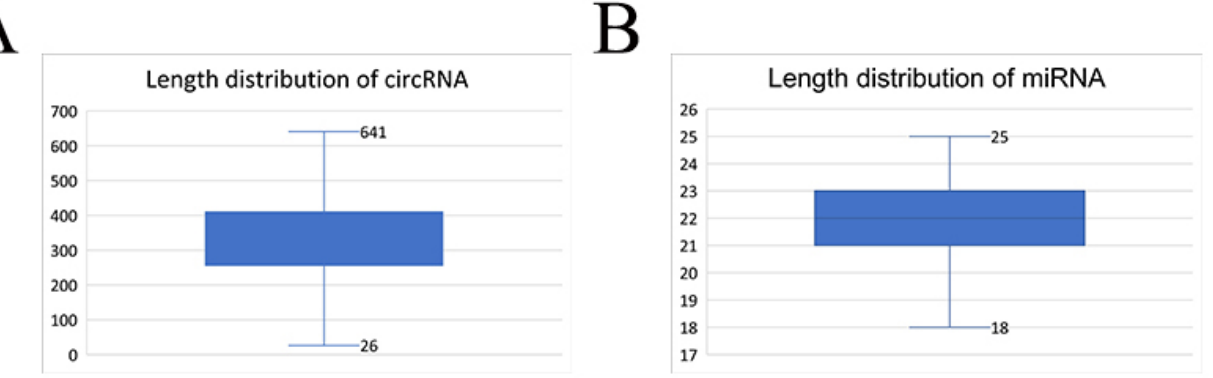
Figure 1. Length distribution of the identified circRNAs ( A ) and miRNAs ( B ).